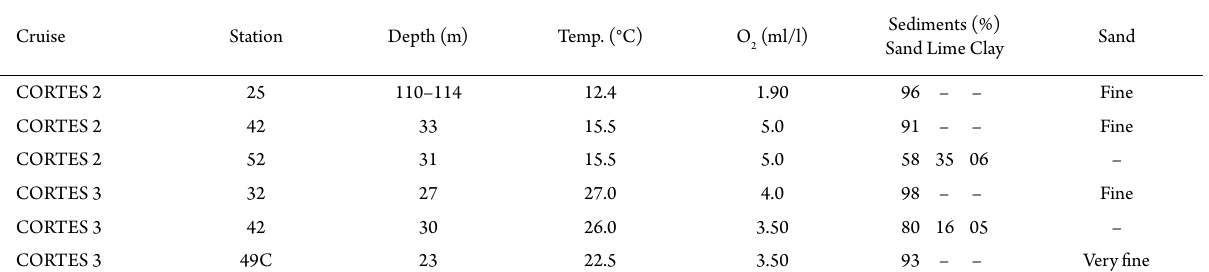
Table 1. Environmental data obtained at bottom level in offshore sampling stations where Malacoplax californiensis was collected.